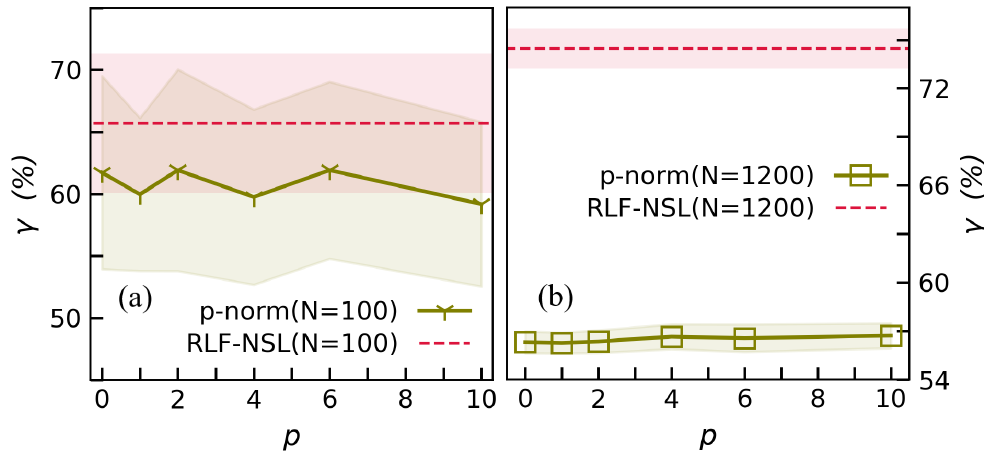
Figure A2. The classification accuracies γ on the IMDb dataset for ( a ) N = 100 and ( b ) N = 1200, obtained by the NSL with the p-norm for different values of p (solid lines with symbols) and with the RLF as the kernel (horizontal dash lines). The shadows show the standard